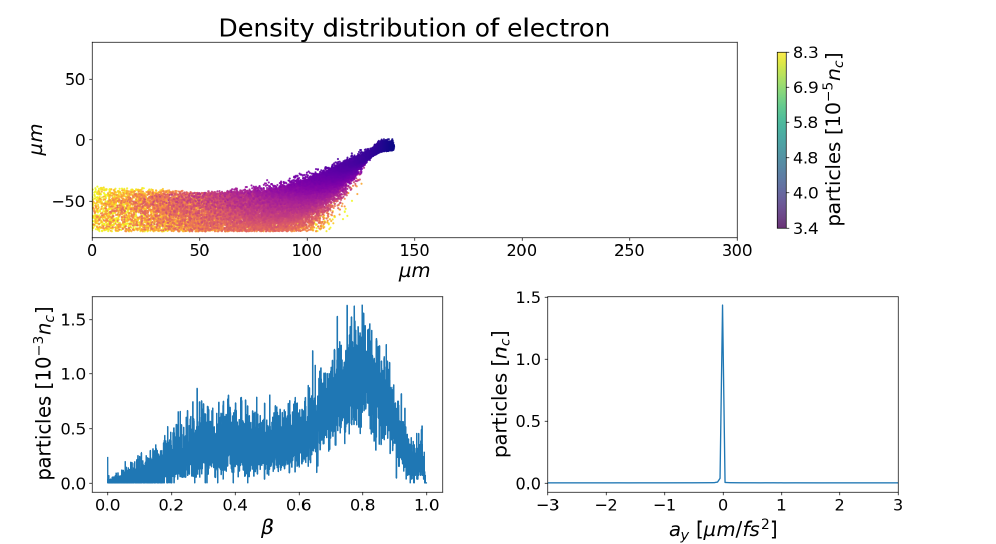
Figure 26. Slide-away electrons. The top figure is the electron density distribution shown by color. The bottom left figure is the velocity distribution in β = v / c , where v is the velocity of the electron and c is the speed of light. bottom right of the figure shows the acceleration of the electron on the y -axis.